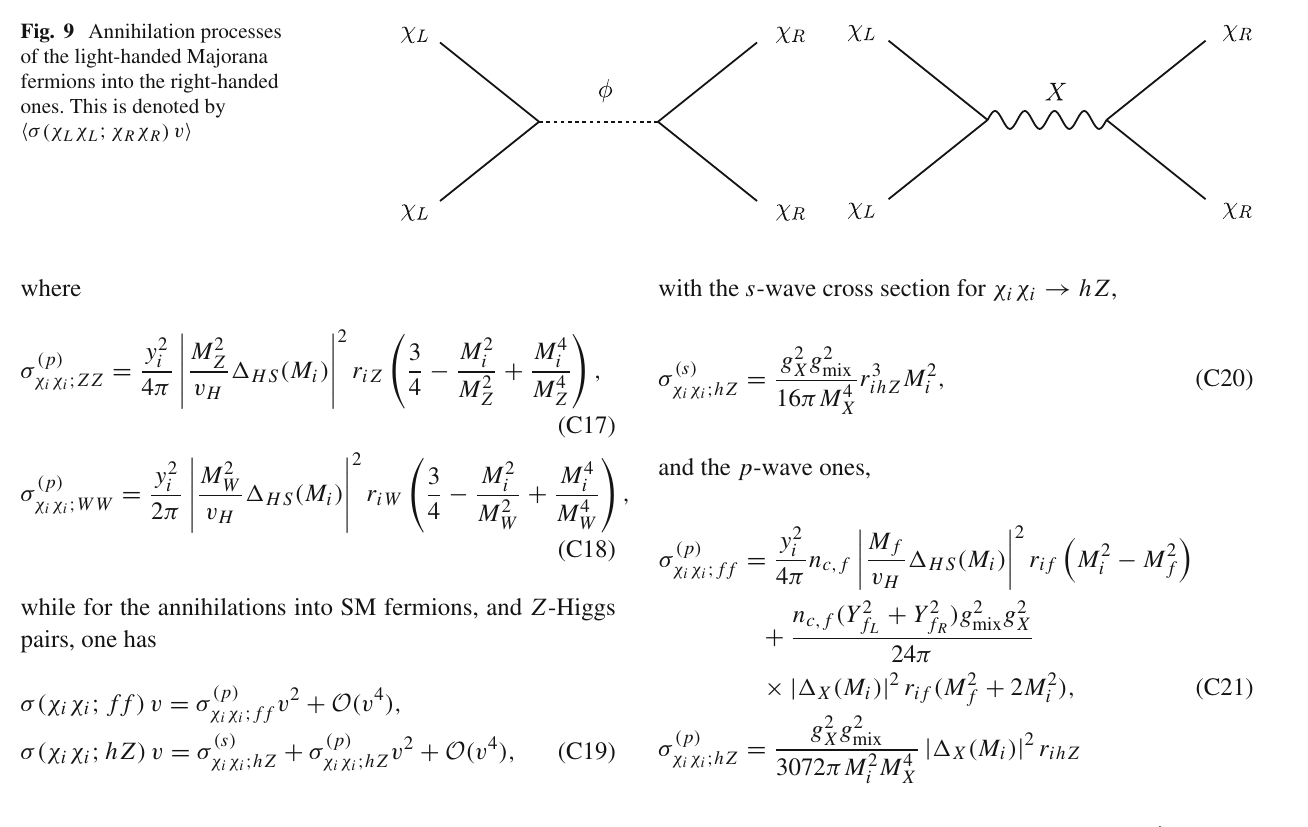
and Z bosons and top-quarks, and f are SM fermions. Contributions from other quarks are neglected since their Yukawa coupling constant is relatively smaller than that of top quark, whereas for the decay process into fermions mediated by X boson, one has to take into account all quark contributions